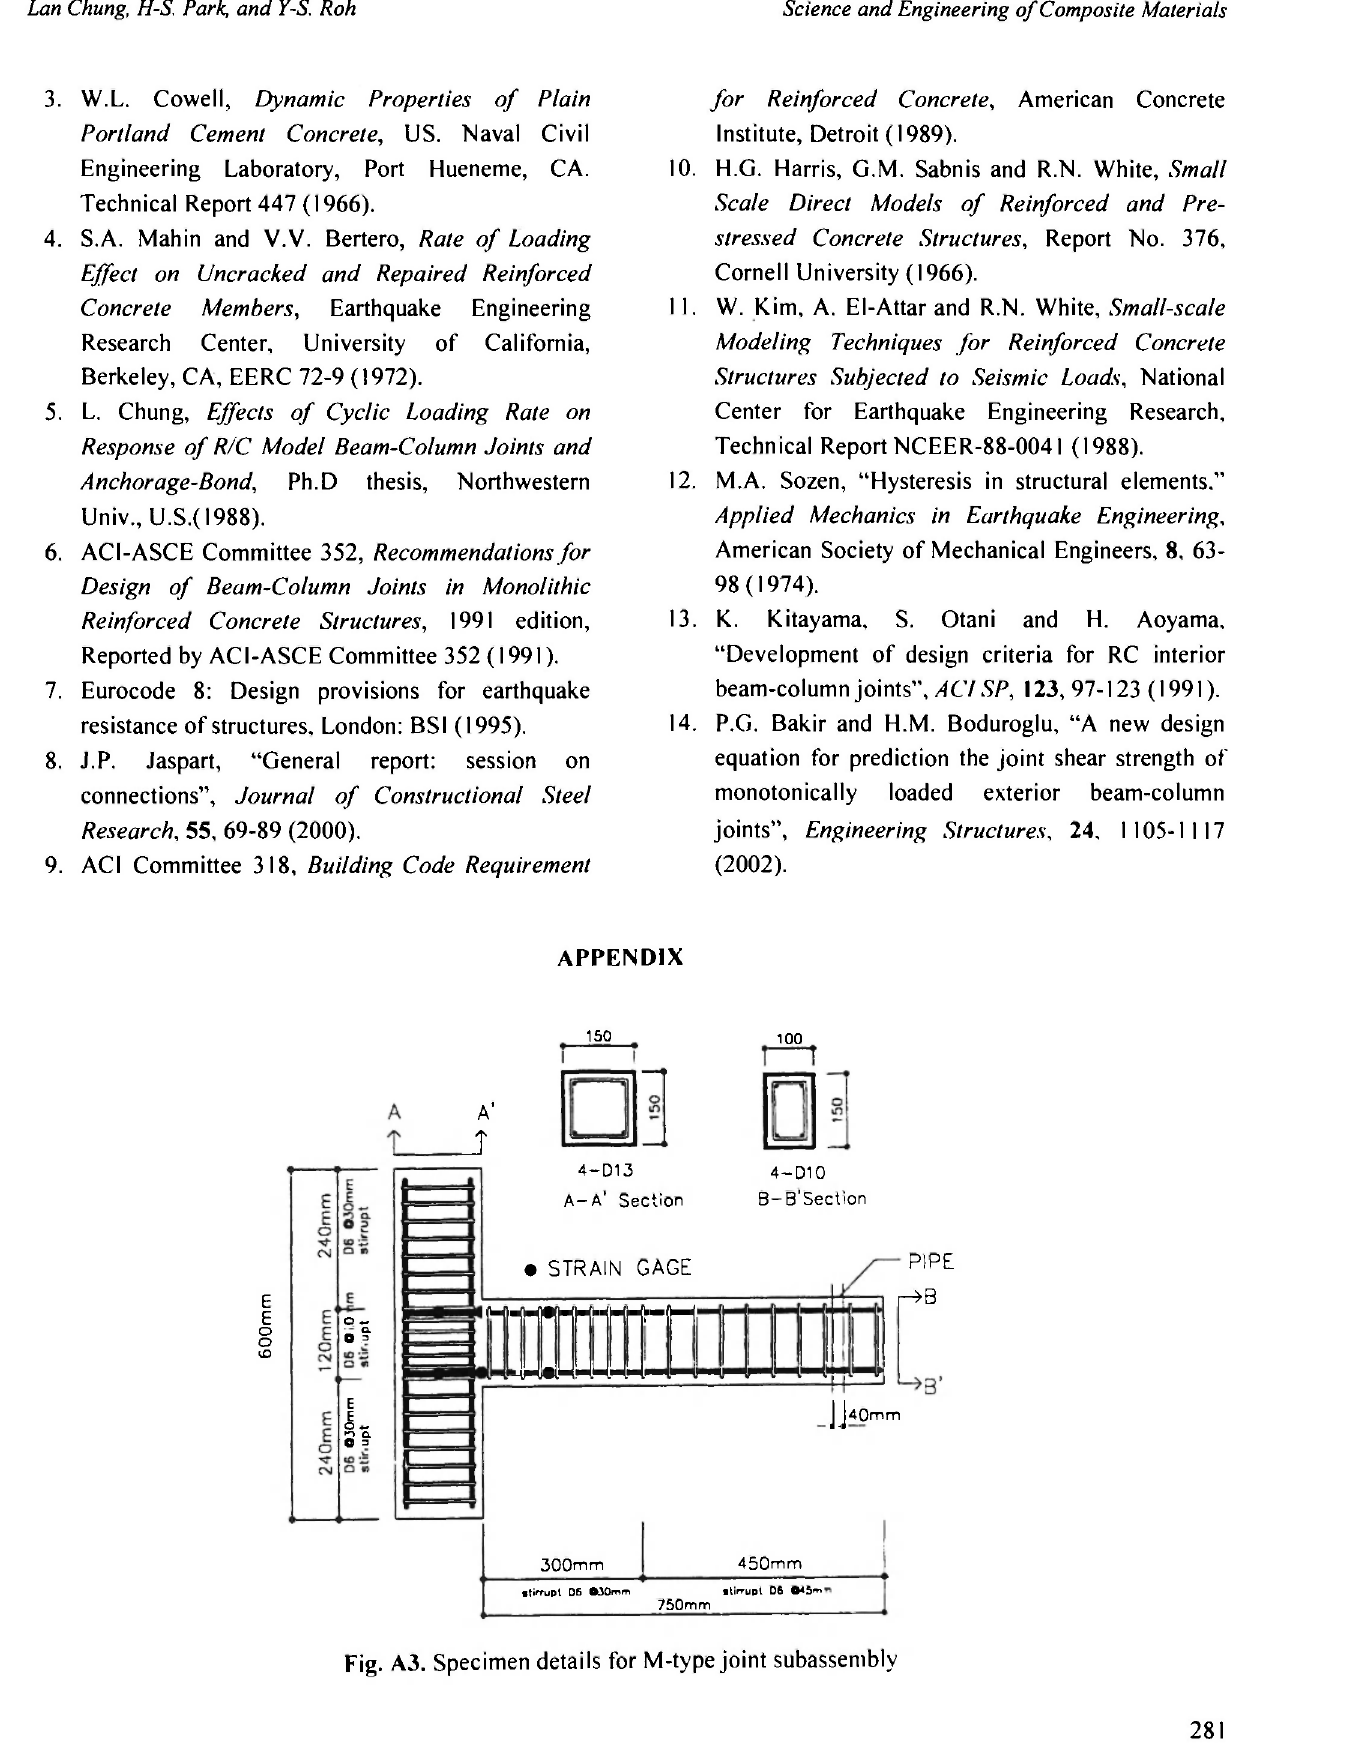
Fig. A3. Specimen details for M-type joint